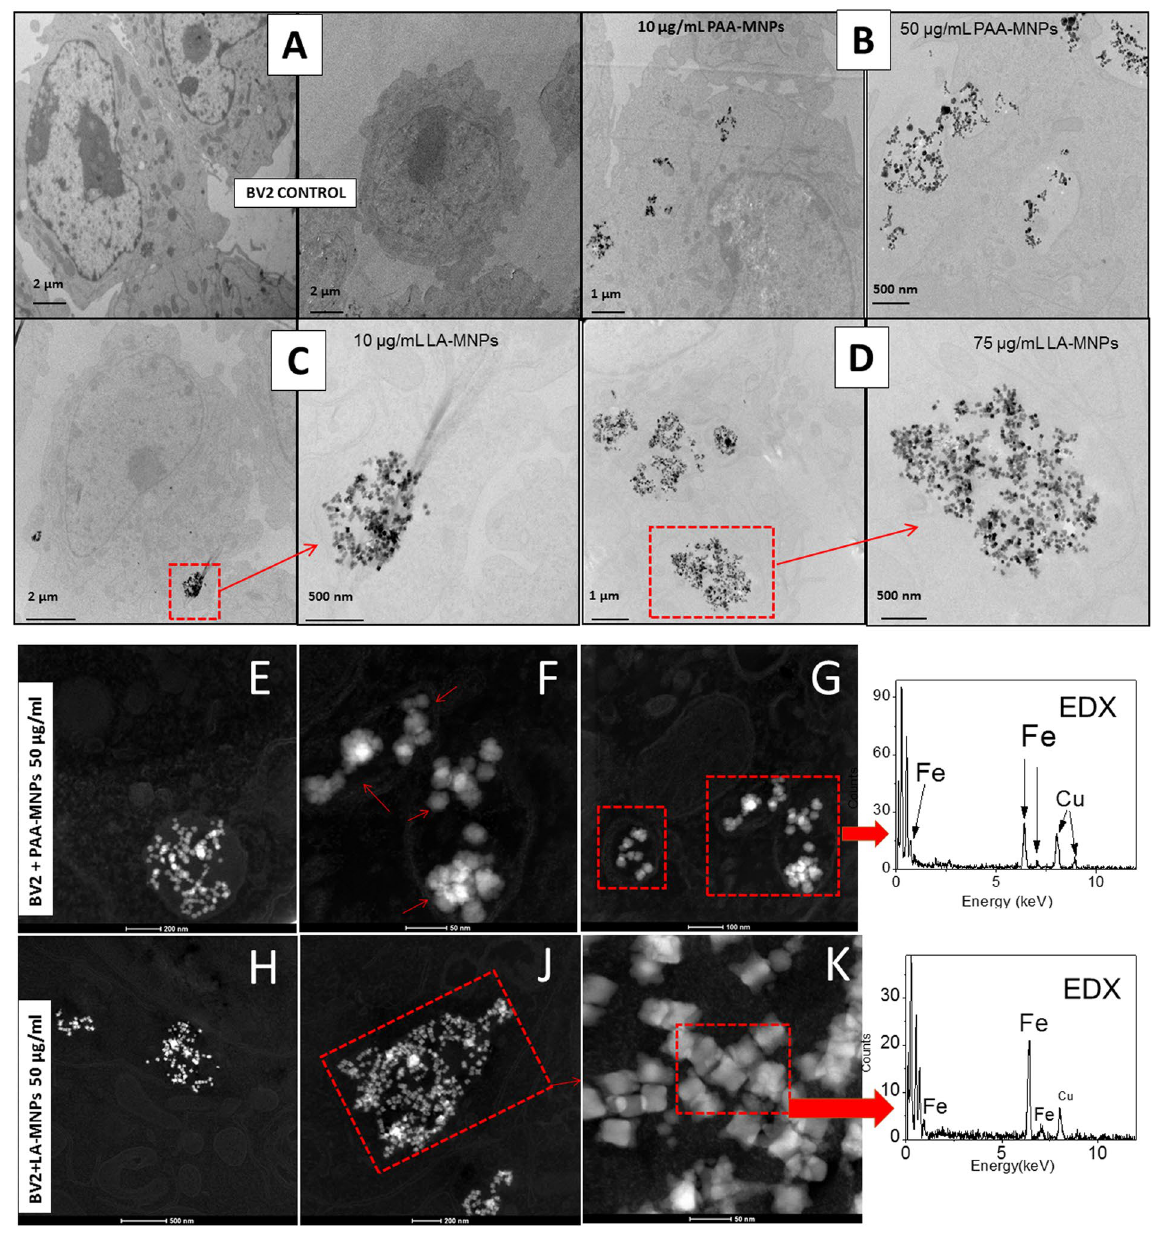
Figure 4. TEM images of BV2 cells with MNPs: ( A ) Control cells ( B ) BV2 incubated with PAA-MNPs 10 and 50 µ g/ml; ( C ) BV2 incubated with LA-MNPs at 10 µ g/ml and magnified image of the clusters; ( D ) BV2 incubated with LA-MNPs at 75 µ g/ml and magnified image of clusters. ( E – G ) STEM images of BV2 cells incubated with 50 μ g/ml of PAA-MNPs; H-K) STEM images of BV2 cells incubated with 50 μ g/ml of LA-MNPs. The last column shows the Energy-dispersive X-ray spectroscopy EDS-HAADF spectra of PAA-MNPs (upper) and LA-MNPs (lower) inside the